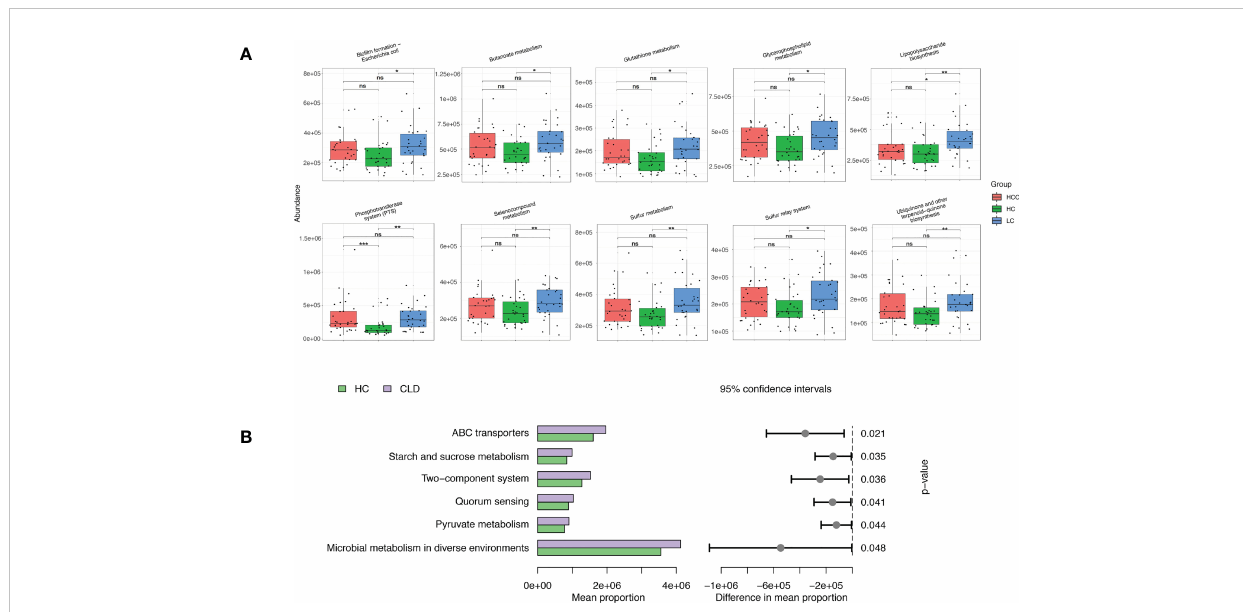
FIGURE 7 Functional analysis of three groups of intestinal microbiomes using 16S rDNA sequencing data indicating metabolic changes of energy substances. PICRUSt2 software was used to predict the composition of known microbial gene functions in different groups and count the functional differences between different samples with HC, HBV-LC, HBV-HCC (A) and HBV-CLD (B) groups. *P < 0.05, **P < 0.01, ***P < 0.001, ns, not signi fi cant.